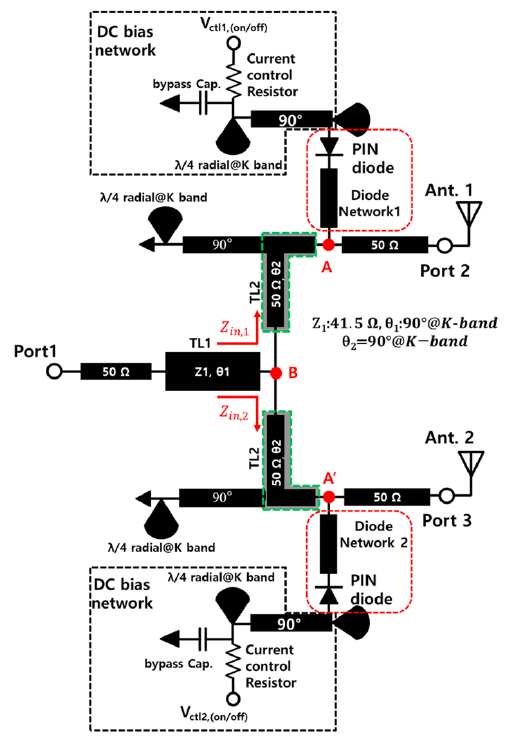
Figure 2. Proposed RF switch for beamwidth reconfiguration.